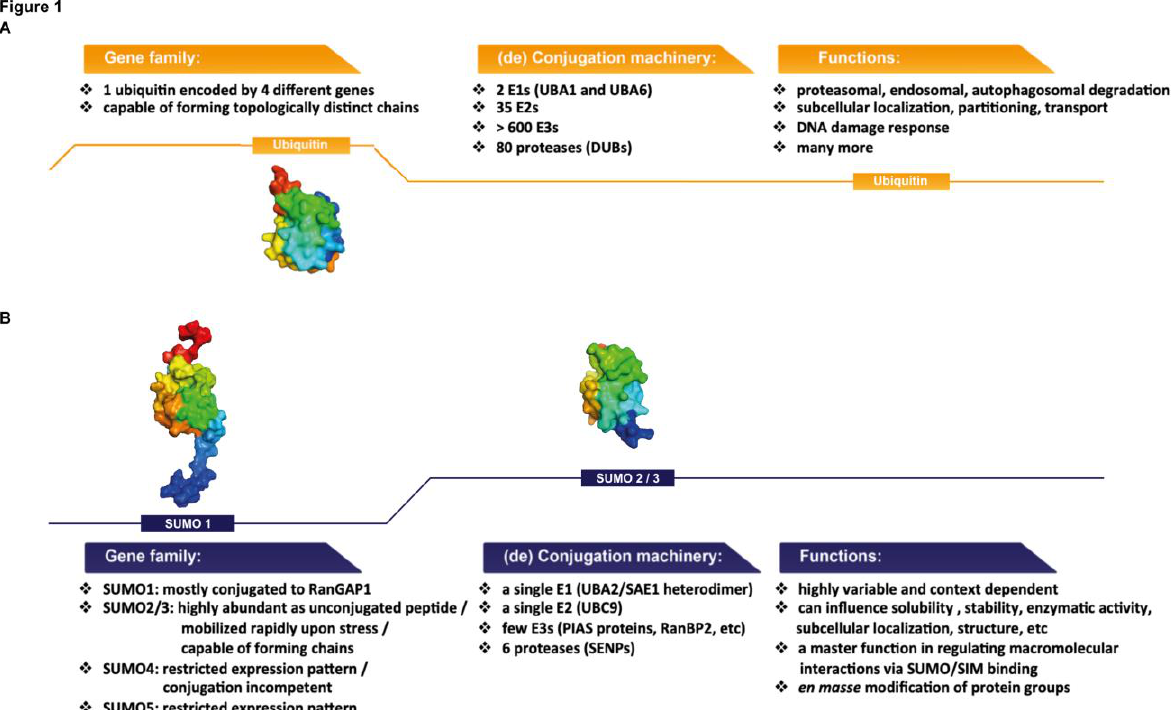
Figure 1. Similarities and disparities between ubiquitin ( A ) and SUMO ( B ), highlighted from a standpoint of structure, functional capabilities and the enzymatic machinery involved. Although SUMO1 shares an 18% amino-acid sequence identity with ubiquitin, the three-dimensional structures of SUMO1, SUMO2/3 and ubiquitin are remarkably similar, all featuring the central ubiquitin core that folds into a “ ββαββαβ ” pattern. The structure of SUMO1 is unique in that a flexible N-terminal extension protrudes from this central core (highlighted in dark blue). Images were generated by PyMOL (SUMO1 PDB: 2n1v, SUMO2/3 PDB: 2n1w, ubiquitin PDB: